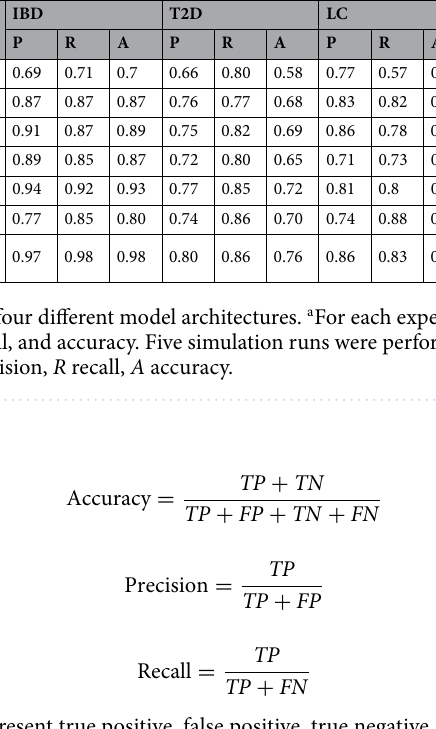
where TP, FP, TN, and FN represent true positive, false positive, true negative, and false negative, respectively. LOOCV was conducted five times and averaged for the evaluation. For genomic features, three runs were con- ducted by randomly selecting new reference samples in each iteration. For the IBD and T2D datasets, macro- and micro-averaged accuracies were the same because both datasets included the same number of positive and negative samples. For the LC dataset, the number of positive and negative samples were similar, resulting in no significant difference between macro- and micro-average performances. To evaluate the performance, five traditional machine learning models (i.e., random forest (RF) 39 , extreme gradient boosting (XGBoost) 40 , principal component regression (PCR), lasso regression 41 , and support vector machine (SVM) 42 were used. All the traditional models were implemented in Python (version 3.6.9). For RF,